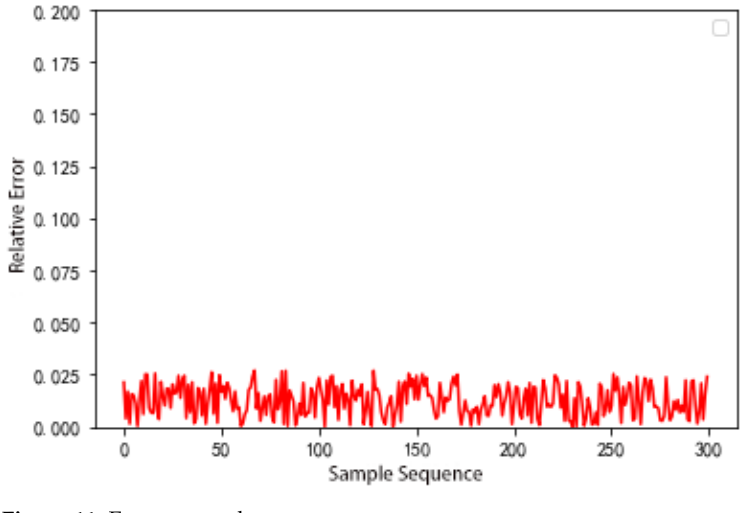
Figure 10. BMIFS-CNN-LSTM images of predicted and actual values.